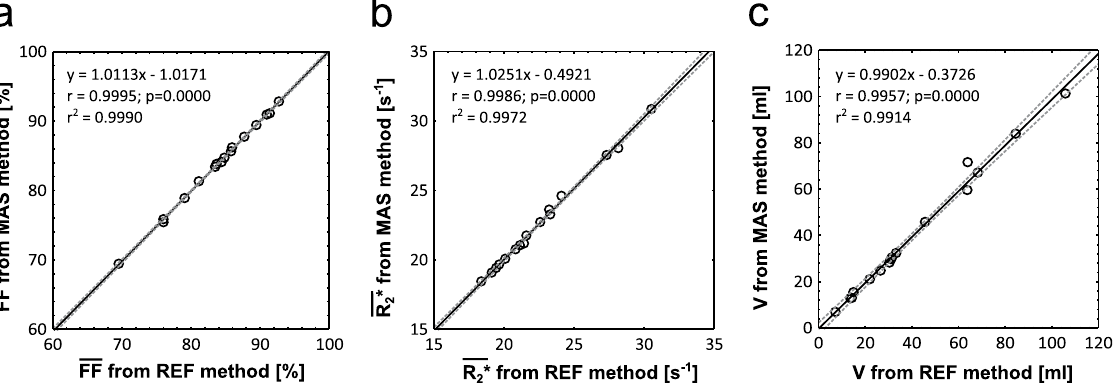
Figure 6. Correspondence in fat fraction, R 2 * and volume measurements. Significant correlations observed between ( a ) mean fat fraction ( FF ), ( b ) mean R 2 * ( ⁎ R ) and ( c ) segmented volume (V), of the cervical- 2 supraclavicular depot (sBAT) as obtained by the multi-atlas segmentation (MAS) method and the semi- automated reference segmentation (REF) method. Dashed lines indicate the 95% confidence interval for the regression line. Number of data points (subjects) = 16. The significance level was not adjusted for multiple